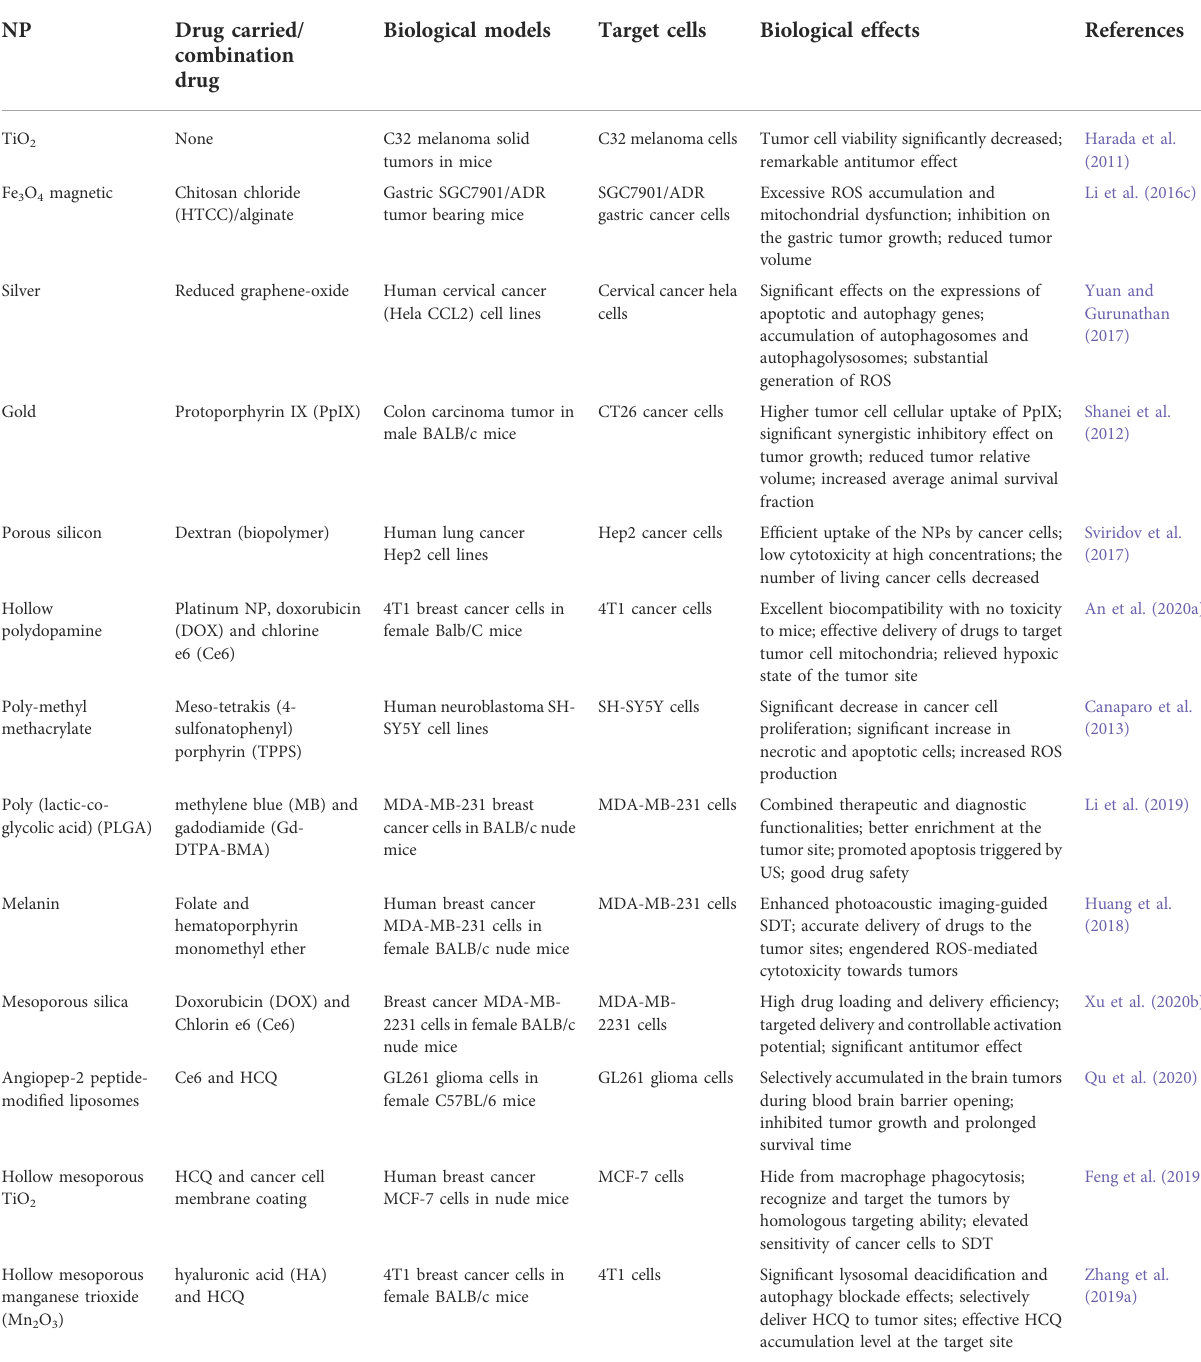
TABLE 2 Summary of